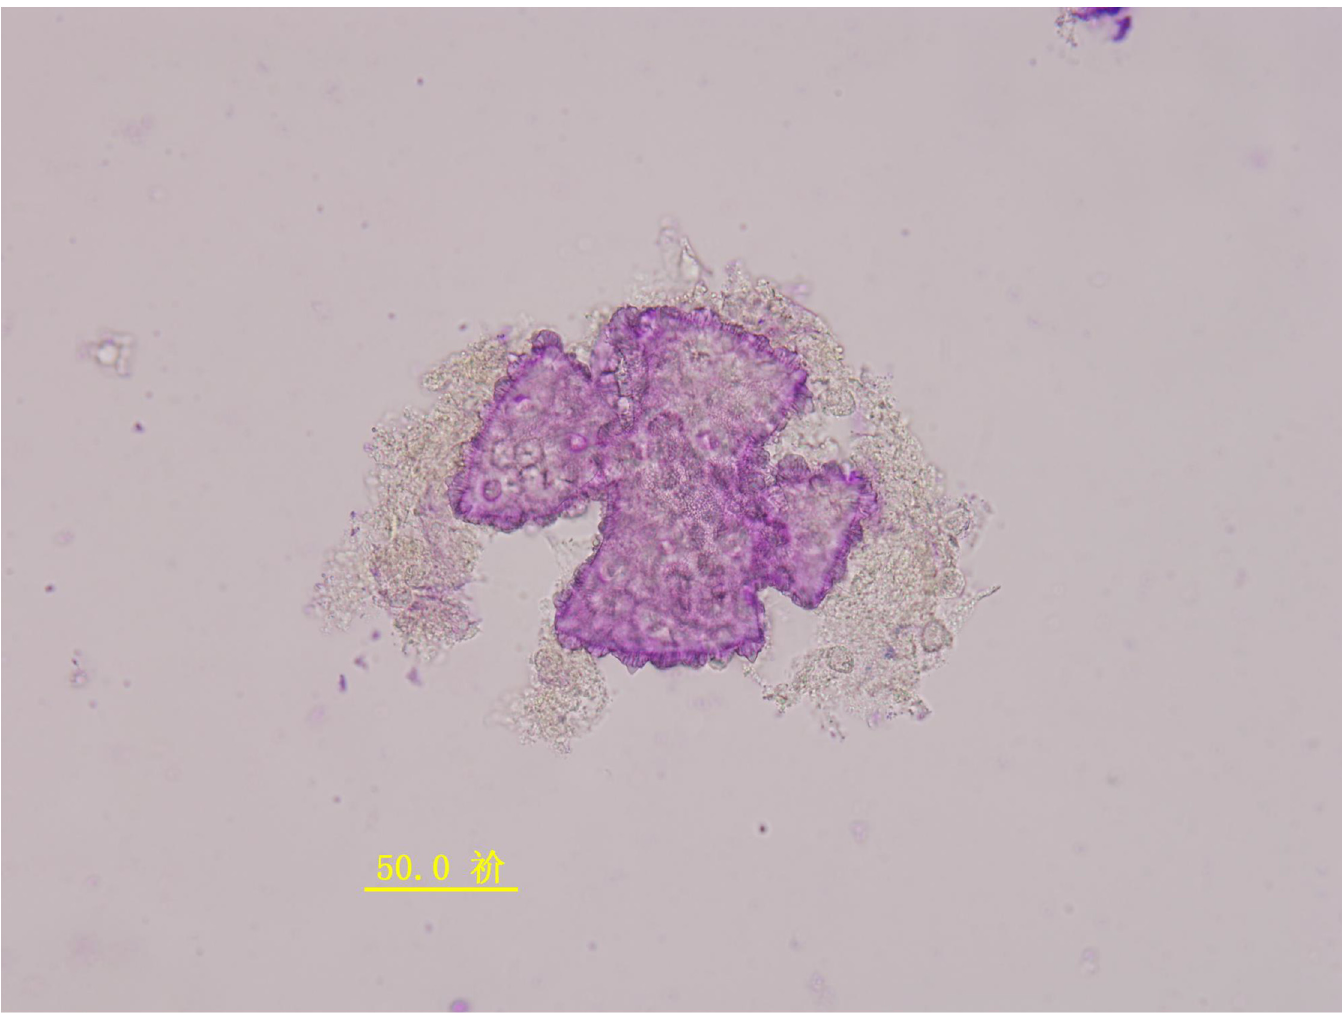
Fig 2. Flowers with two kind color of this triple hybrid at the same time (pink and white) and the stigma and stamen with yellow pollen grains of this hybrid.